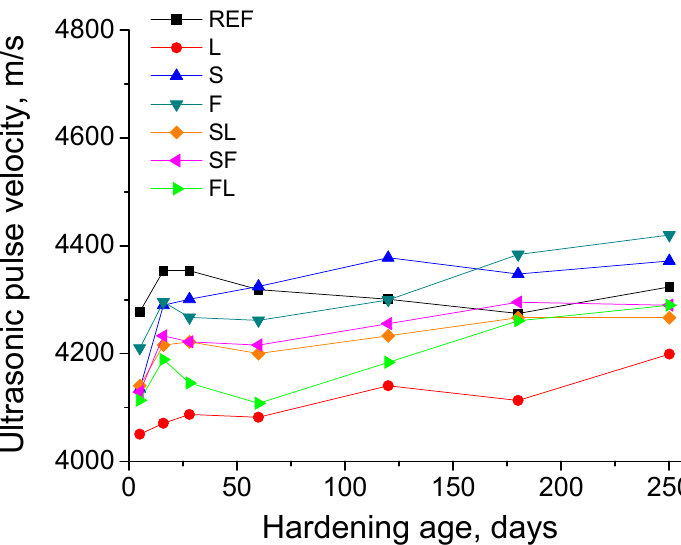
Figure 9. Ultrasonic pulse velocity results for the analyzed binders.